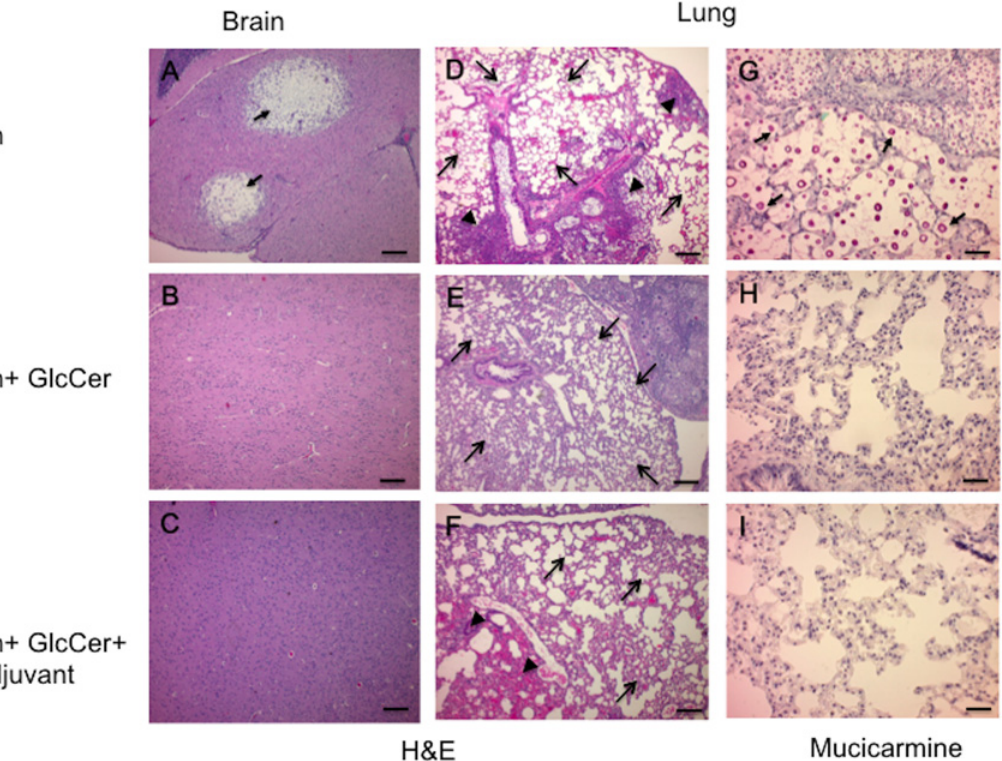
Fig 3. Histopathology of lungs and brain of mice infected with C . neoformans and treated with GlcCer vs. untreated mice. A) Brain of untreated mice stained with H&E. Colonization of C . neoformans (Cn) cells in the brain is shown with arrows. Histology was performed 20 days post-infection. B & C) Brain of infected mice treated with GlcCer or GlcCer + FA. Histology was performed 20 days post-infection. Images showed no abnormality in the brain tissue and no C . neoformans cells was found, confirming CFU data illustrated in Fig 2C , 2D and 2G ) Lungs of untreated mice stained with H&E or mucicarmine. Histology was performed 20 days post-infection. Significant lung inflammation is present (arrowheads in D), where the lung tissue is infiltrated with numerous macrophages, lymphocytes and neutrophils. C . neoformans cells are readily visible in these areas (not shown) and in the alveoli (arrows in G). E & H) Lungs of mice treated with GlcCer and stained with H&E or mucicarmine. Histology was performed 90 days post-infection. Arrows in E illustrate normal lung structure. F & I) Lung of mice treated with GlcCer + adjuvant and stained with H&E or mucicarmine. Histology was performed 90 days post-infection. Arrows in F illustrate normal lung structure. Arrowheads in F illustrate some lung inflammation with no C . neoformans cells present at this particular site of inflammation (I), although they were present in other fields. Three mice per group were used in all histology experiments. The images shown are representative fields of the entire organ. Black bar in A, B an C, 200 μ m; black bar in D, E and F, 200 μ m; black bar in G, H and I, 40 μ m.